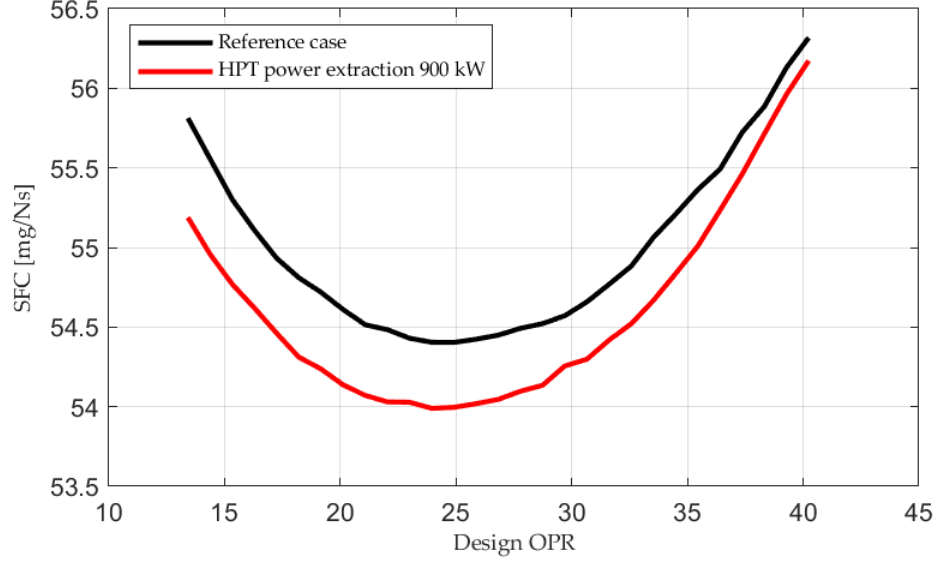
Figure 14. Point 2 of the mission. SFC plotted versus design point OPR.